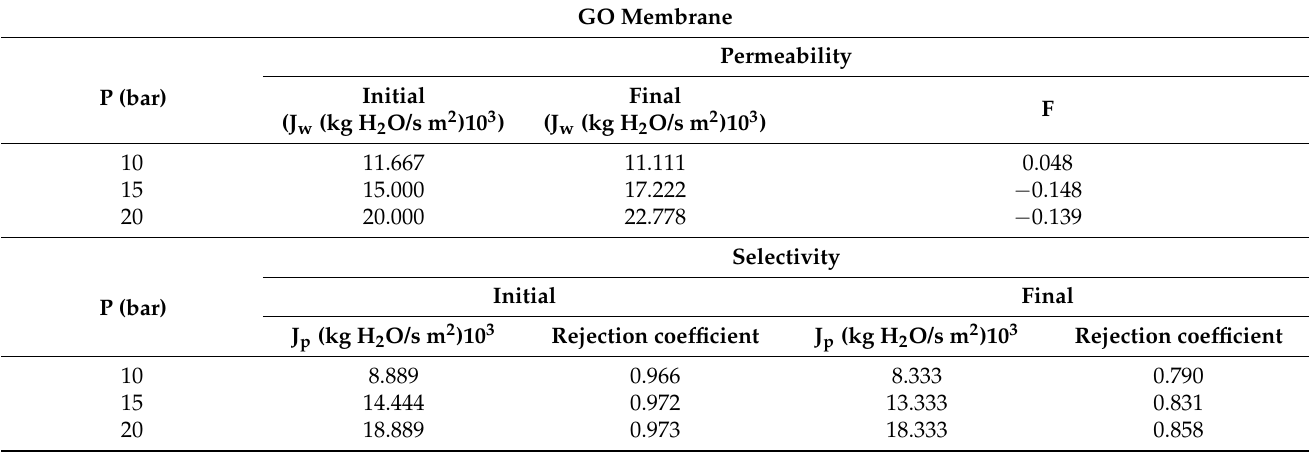
Table 6. Initial and final permeate mass flows from the permeability and selectivity tests, rejection results of the saline solutions, and fouling factor of the membrane modified with graphene